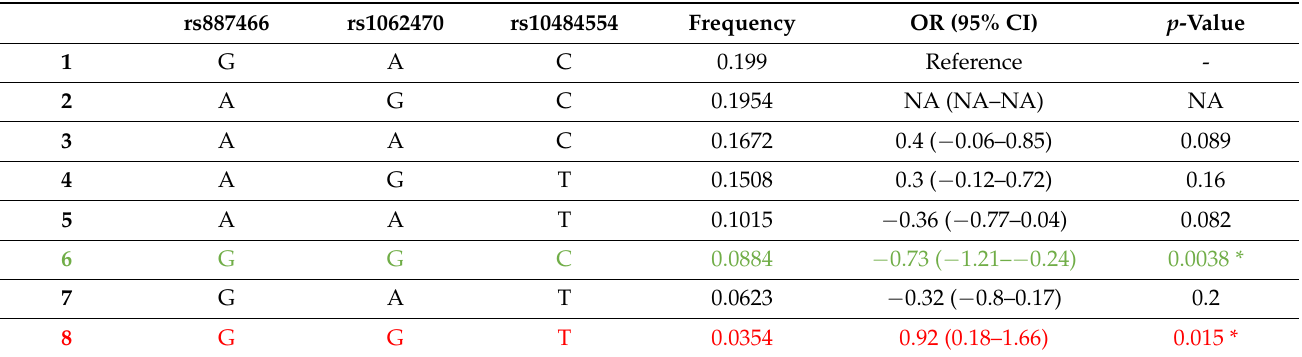
Table 5. Haplotype association with Disease Severity.